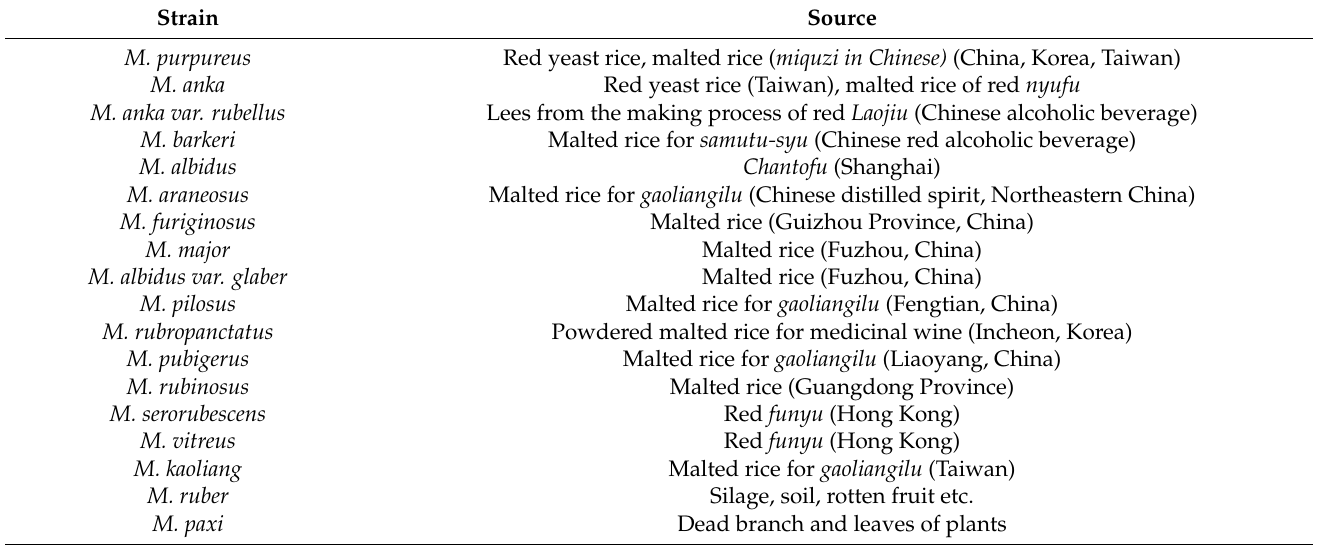
Table 1. Typical Monascus fungi and their isolation source.